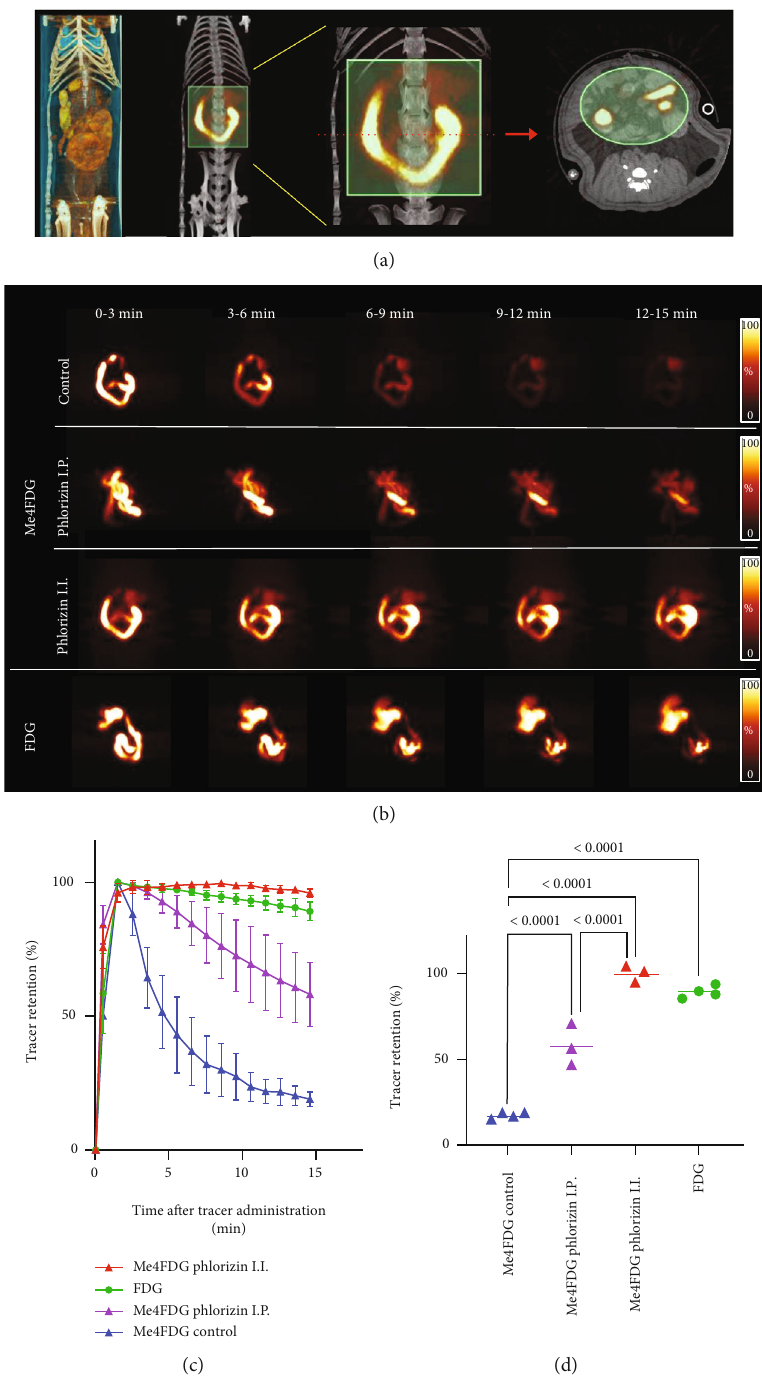
Figure 2: Results of intestinal [ 18 F]Me4FDG PET imaging. (a) Representative volume rendered image, coronal PET/CT fusion image, and coronal and transaxial volume of interest (VOI; light green area) of a rat. (b) Coronal maximum intensity projection images of dynamic [ 18 F]Me4FDG PET over 15min after radiotracer administration in untreated controls (upper rows) and after intraperitoneal (I.P., middle rows) and intra-intestinal (I.I., lower rows) treatment using the SGLT inhibitor phlorizin. In I.I. animals treated with this drug, tracer retention remained stable, while in untreated I.I.-administered controls, a markedly reduced radiotracer accumulation was observed over time. In the last column, [ 18 F]FDG serving as a comparator also demonstrated slow radiotracer clearance in untreated animals. Quantitative comparison of radiotracer retention among all groups, displayed as (c) time-activity curves and (d) tracer retention at 15min. Control [ 18 F]Me4FDG group showed rapid decrease of I.I.-injected radioactivity (blue). I.I. phlorizin-pretreated [ 18 F]Me4FDG group (red) showed little decrease, similar to (untreated) I.I.-injected [ 18 F]FDG animals (green, serving as reference). I.P. phlorizin- pretreated [ 18 F]Me4FDG rats (purple), however, demonstrated moderate decrease during image acquisition. Bars indicate mean ± SD